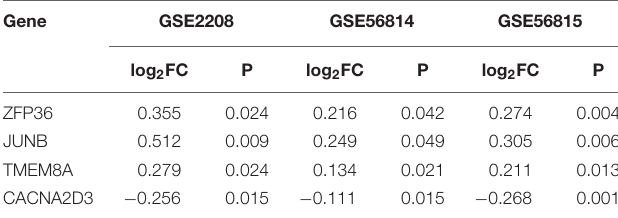
TABLE 2 | Genes expressed consistently across all three sets of